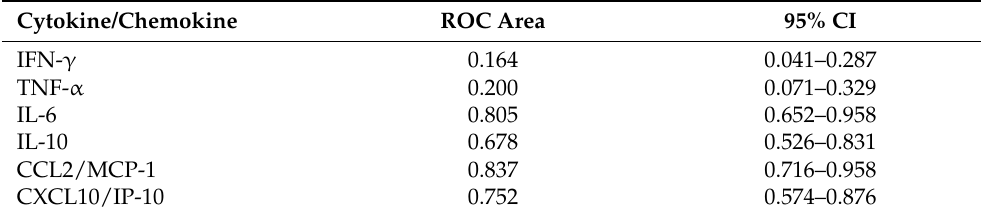
Table 2. Area under the ROC curve of cytokines and chemokines to predict severity in SARS-CoV-2